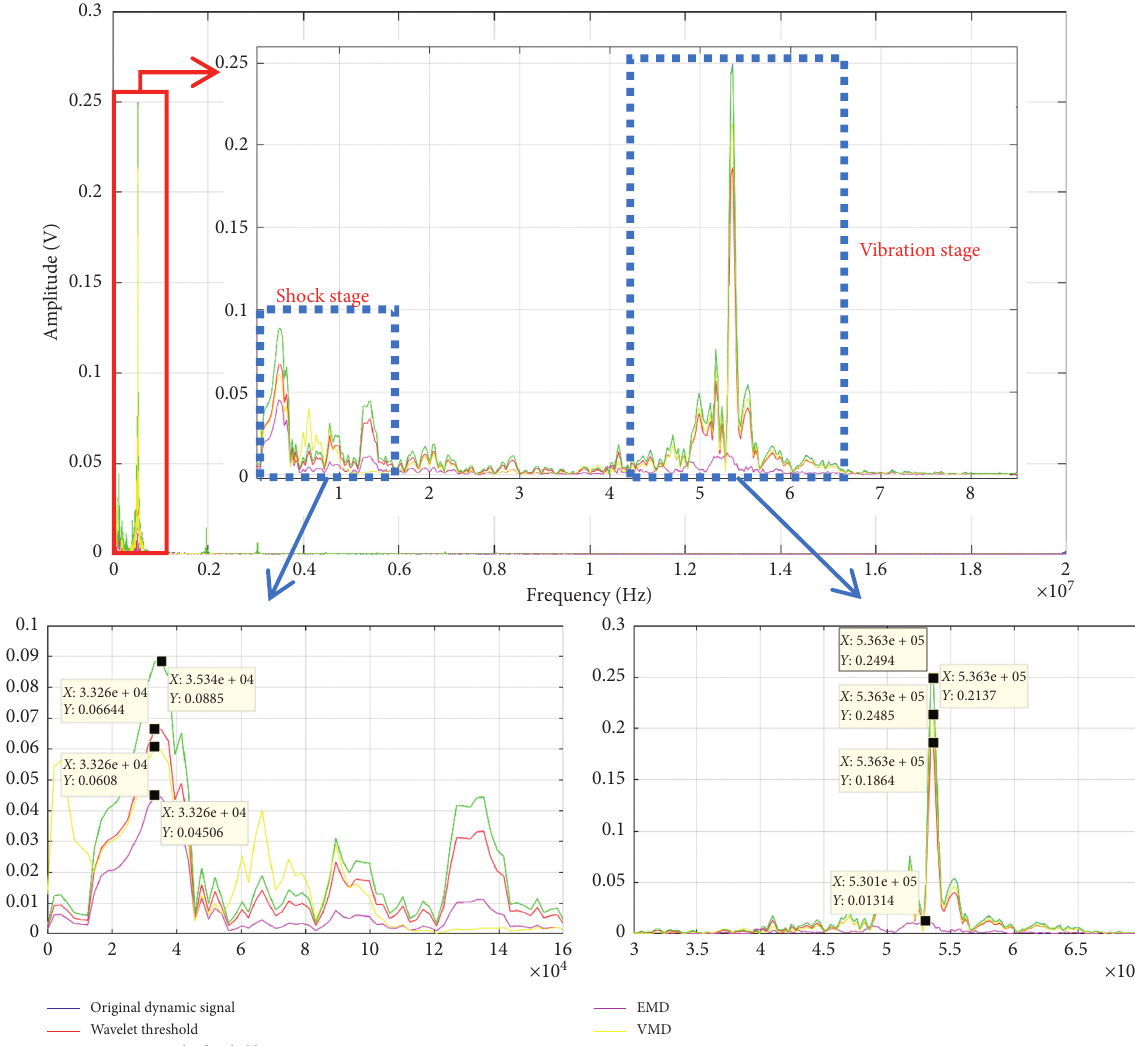
Figure 14: Frequency characteristics of signals after denoising with different denoising methods. Table 4: Performance evaluation of different denoising algorithms in dynamic processing.